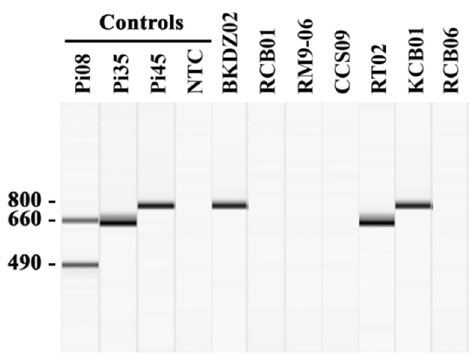
Figure 2. Identification and genotyping of P. insidiosum by multiplex PCR. The multiplex PCR amplifies the rDNA sequence from a gDNA sample extracted from water-isolated P. insidiosum -suspected colonies. The amplicon sizes are assessed by using the capillary electrophoresis-based QIAxcel advanced system (Qiagen) (see the methods). The positive controls include gDNA samples extracted from P. insidiosum strains Pi08 (Clade-I genotype; amplicons: 490- and 660-bp bands), Pi35 (Clade-II genotype; amplicon: 660-bp band), and Pi45 (Clade-III genotype; amplicon: 800-bp band). The PCR reaction with no gDNA template serves as the negative control [no template control (NTC)]. The multiplex PCR results of 7 randomly-selected P. insidiosum -suspected organisms (IDs: BKDZ02, RCB01, RM9-06, CCS09, RT02, KCB01, and RCB06) are shown in the Figure.